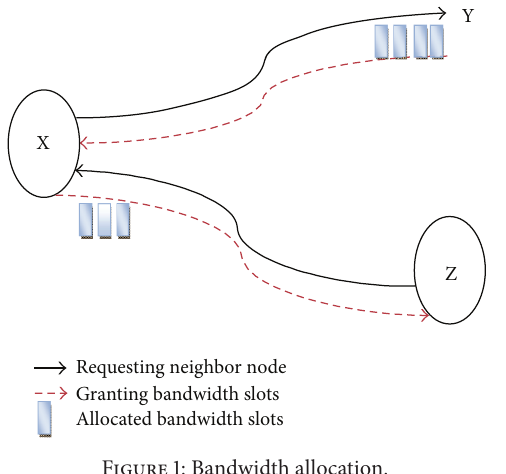
Figure 1: Bandwidth